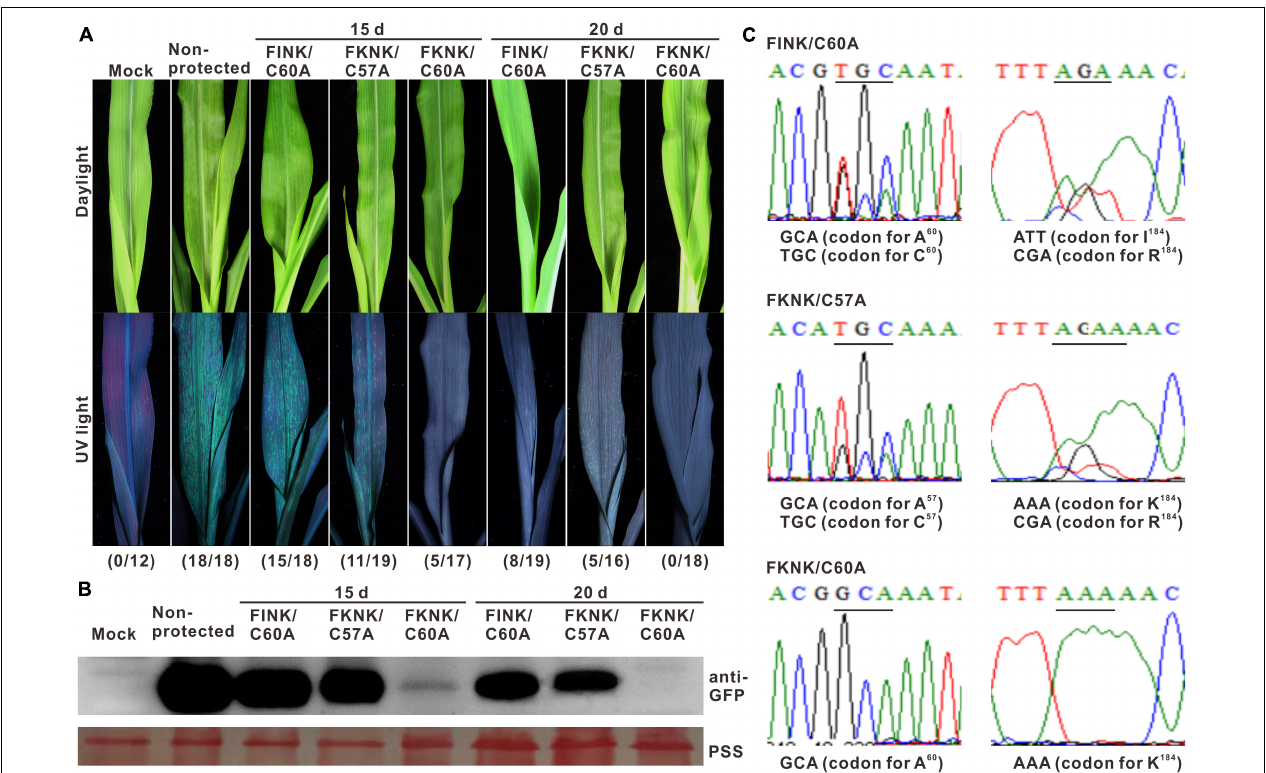
FIGURE 4 | Cross protection efficacy of SCMV double-mutants against severe strain. (A) Symptoms of the maize plants challenged with SCMV-GFP at 20 days post-challenge inoculation with intervals of 15 or 20 dpi. Mock, the maize plants were inoculated with phosphate-buffered saline. Non-protected, the mazie plants were inoculated with pCB301-Rz vector. The numbers of symptomatic/inoculated maize plants were marked in brackets. (B) Western blotting analysis of the GFP accumulation levels in the maize plants challenged with wild-type SCMV-GFP at 20 days post-challenge inoculation. The ponceau S staining (PSS) shows sample loadings. (C) With the interval of 20 days, the sequencing result of HC-Pro RT-PCR products from the maize plants protected with FINK/C60A, FKNK/C57A or FKNK/C60A at 20 days post-challenge inoculation. The sites of point mutations in SCMV HC-Pro were underlined and the corresponding amino acid residues were indicated. The experiments were repeated thrice